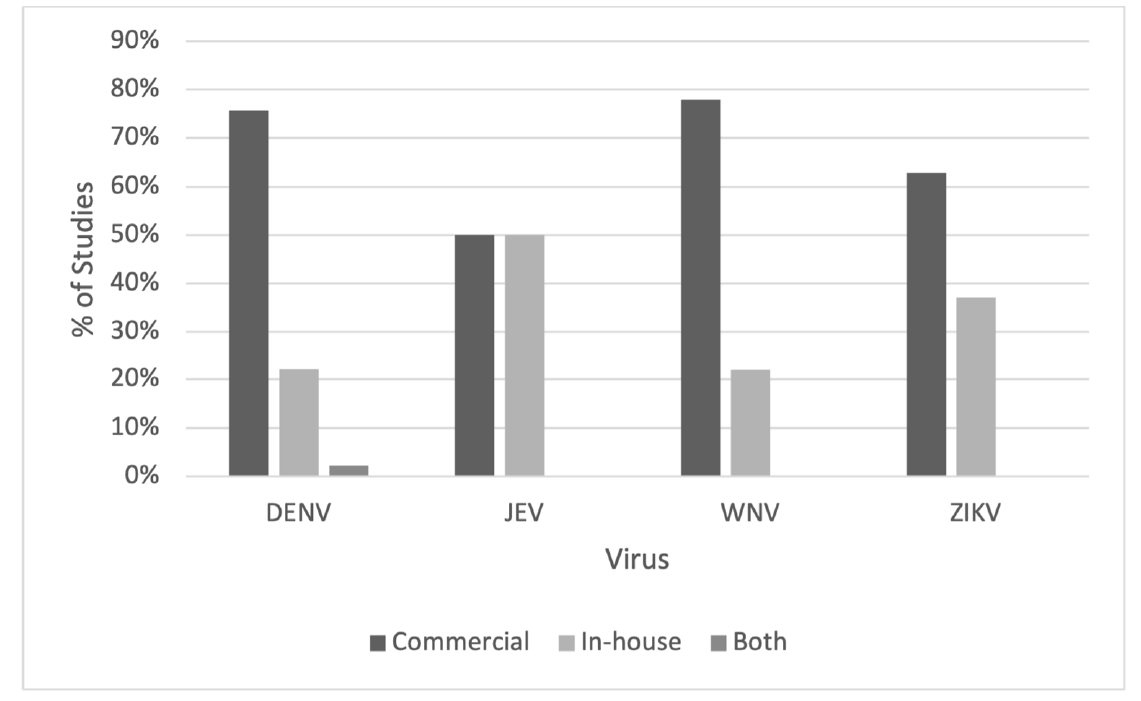
Figure 3. Distribution of ELISA types by virus.